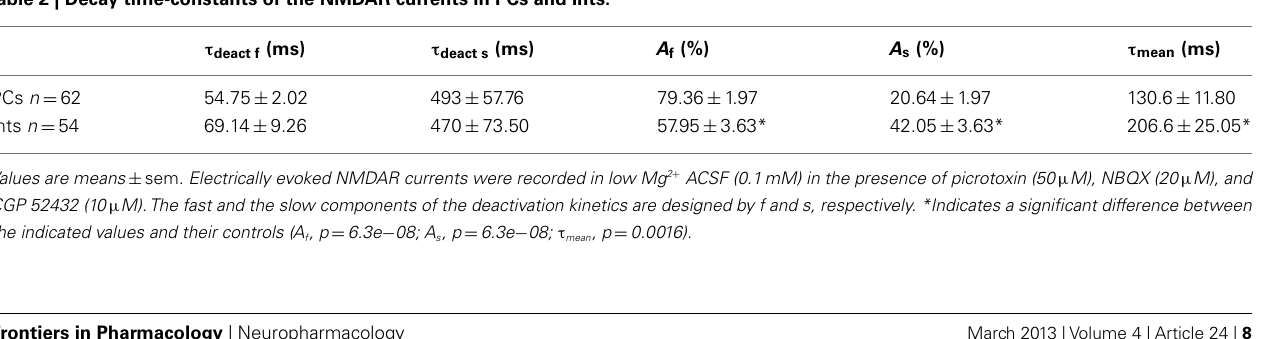
Table 2 | Decay time-constants of the NMDAR currents in PCs and